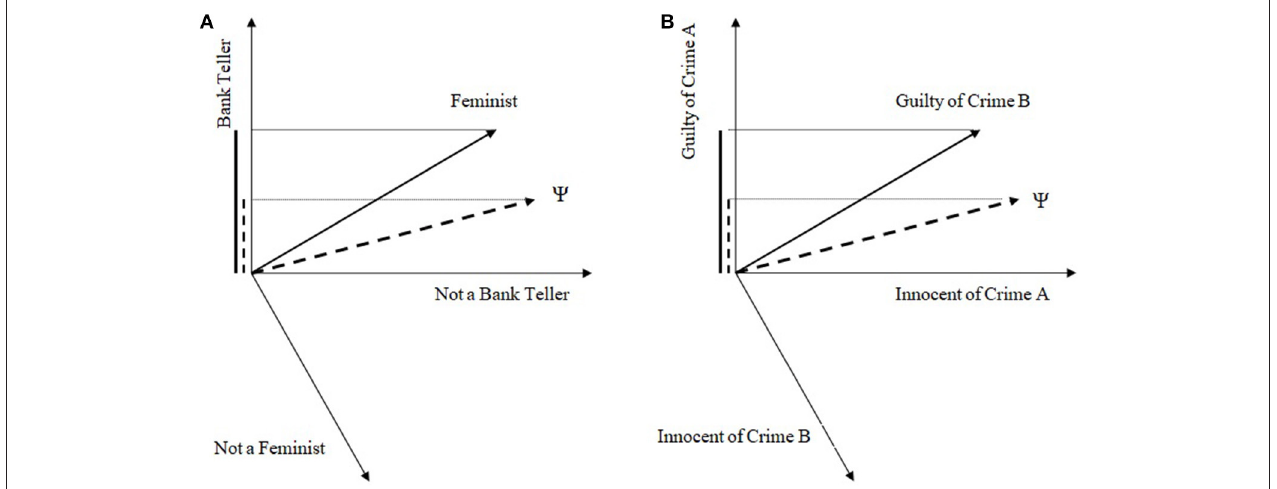
FIGURE 3 | An illustration of the QP approach for the (single) conjunction fallacy in (A) the classic “Linda problem” and in (B) legal decision